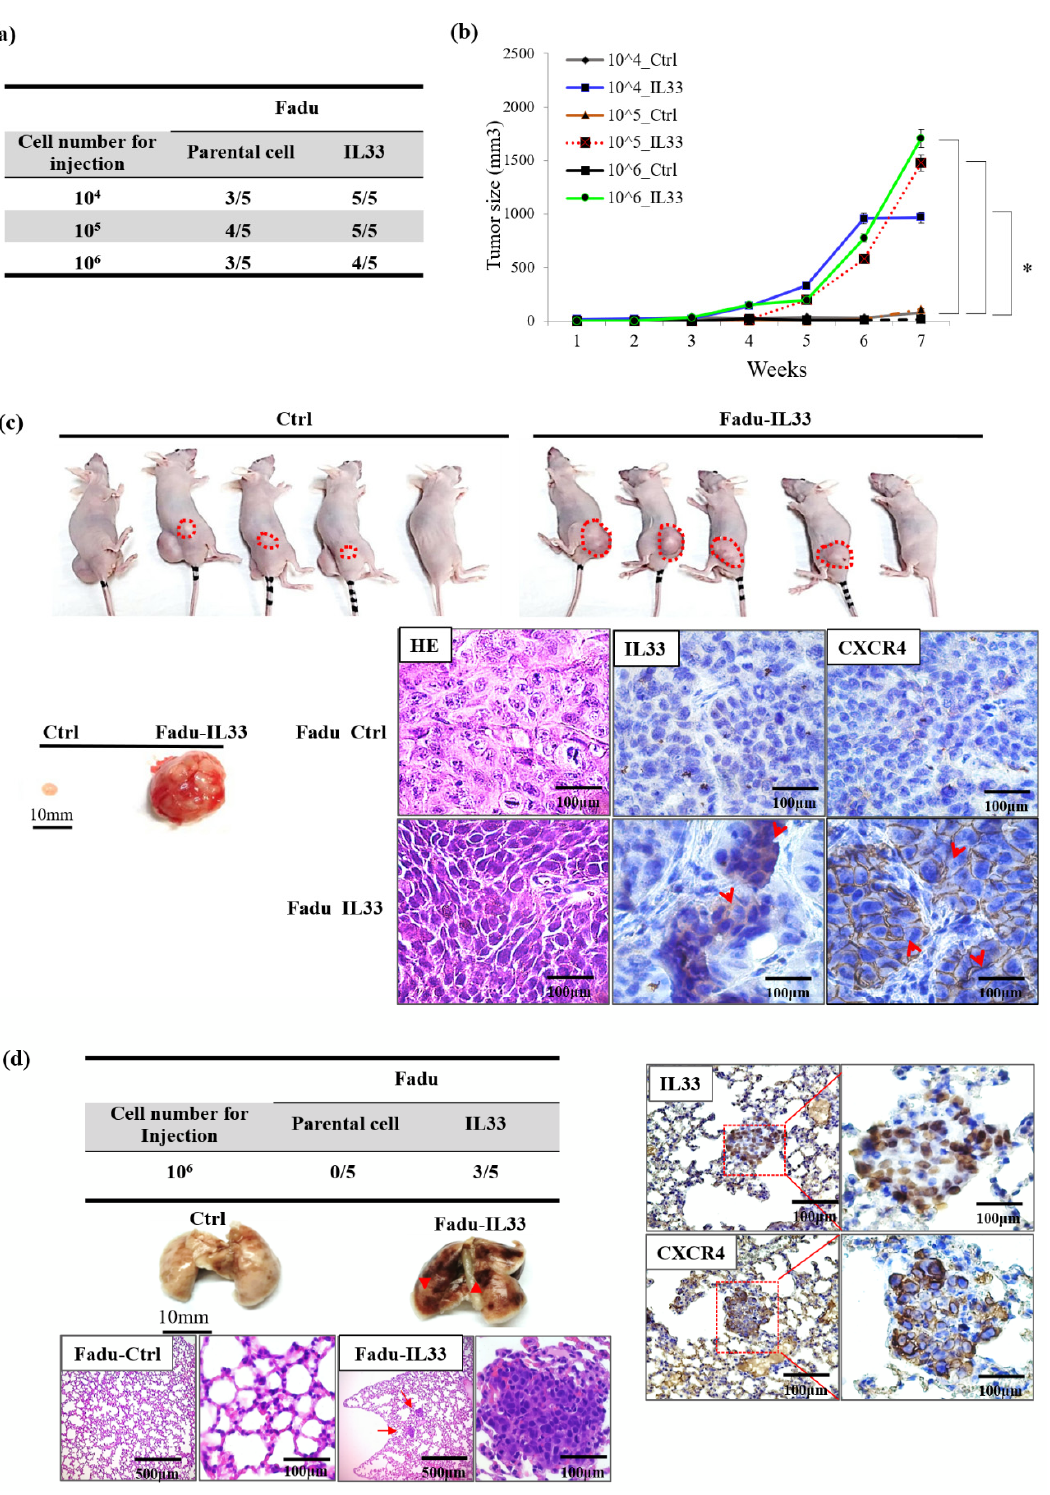
Figure 4. Xerographic evidence from the stable clones of the IL-33-overexpressing HNSCC cells highlights that tumorigenicity and metastases is associated with IL-33 expression/CXCR4 signaling. ( a ) The in vivo study ( n = 5 in each group) showed greater tumorigenicity in the IL-33-overexpressing stably cloned FaDu cells compared with the control cells. ( b ) Time-dependent tumor growth differences were observed in the stably cloned FaDu cells compared with the control cells. ( c ) The stably cloned cell-induced tumors (right) were significantly larger than the tumors induced by the control cells (left). A marked size difference in the tumors dissected from a representative BALB/c nude mouse was found following the subcutaneous inoculation of the stably cloned FaDu cells and the control cells. The immunohistochemical analysis of the tumor nodules revealed the overexpression of both IL-33 and CXCR4 in the stably cloned FaDu cells (magnification,